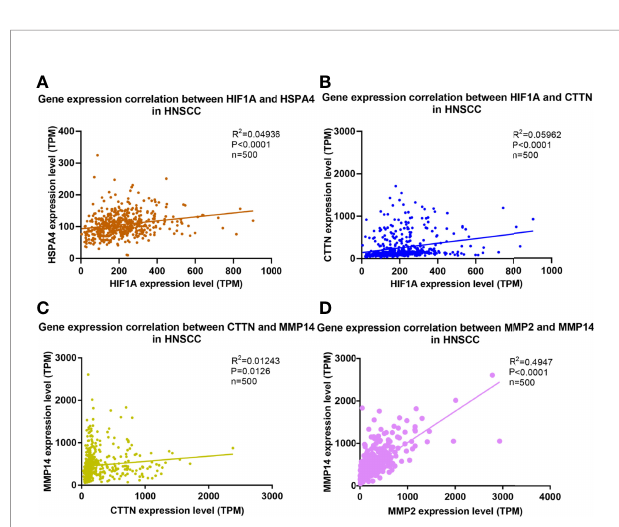
FIGURE 4 | Correlation and regression of HSPA4, HIF-1A, MMP2, MMP14, and CTTN in TCGA database. Correlation and regression of (A) HSPA4, HIF-1A (B) HIF-1A, CTTN (C) CTTN, MMP14 (D) MMP2, and MMP14 in TCGA